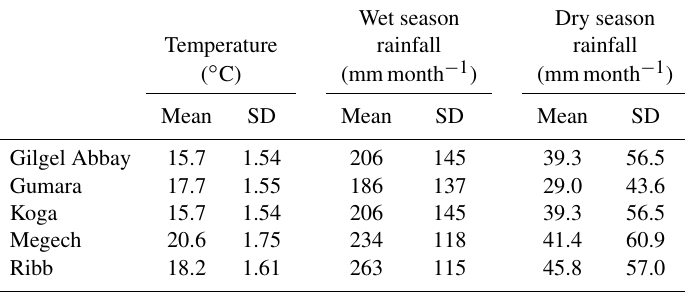
Table 6. Mean and standard deviation values for temperature, wet-season rainfall, and dry-season rainfall in each